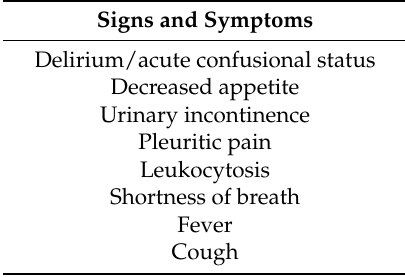
Table 1. Clinical Features of Community Acquired Pneumonia in the